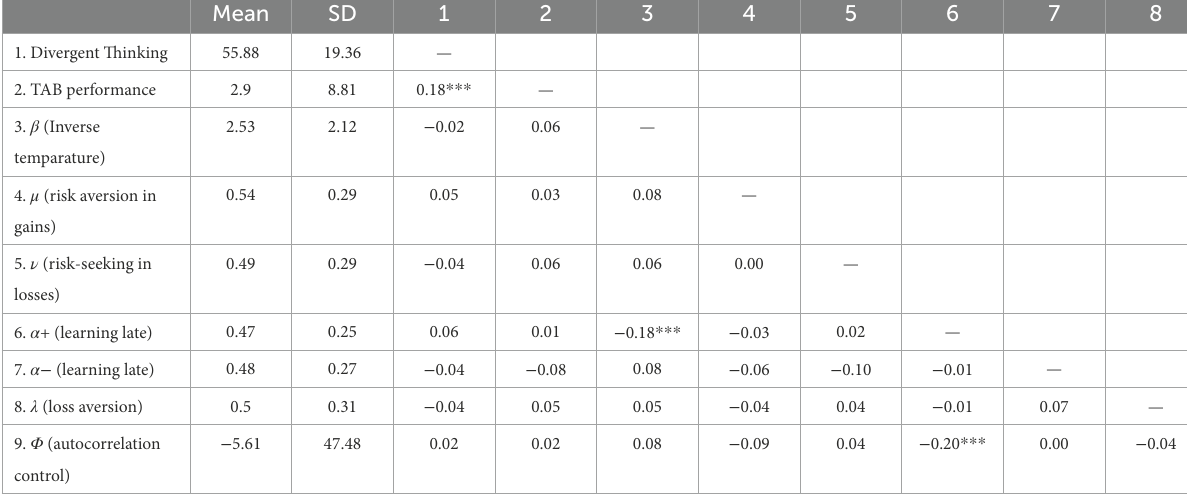
TABLE 1A Descriptive statistics (pooled sample).